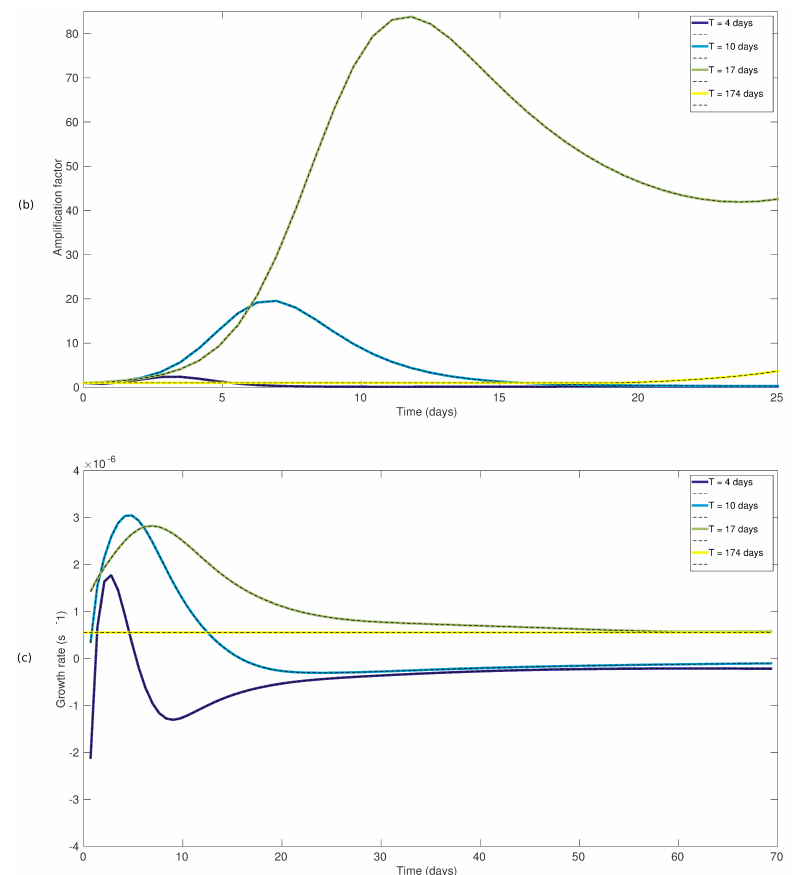
Figure 9. Time evolution of the optimal perturbations for time intervals τ = 4, 10, 17 and 174 days implemented in the non-linear QG model. ( a ) Amplification factor (non-dimensional) against time (days); ( b ) Zoom of (a) between 0 and 25 days; ( c ) Growth rate (s − 1 ) against